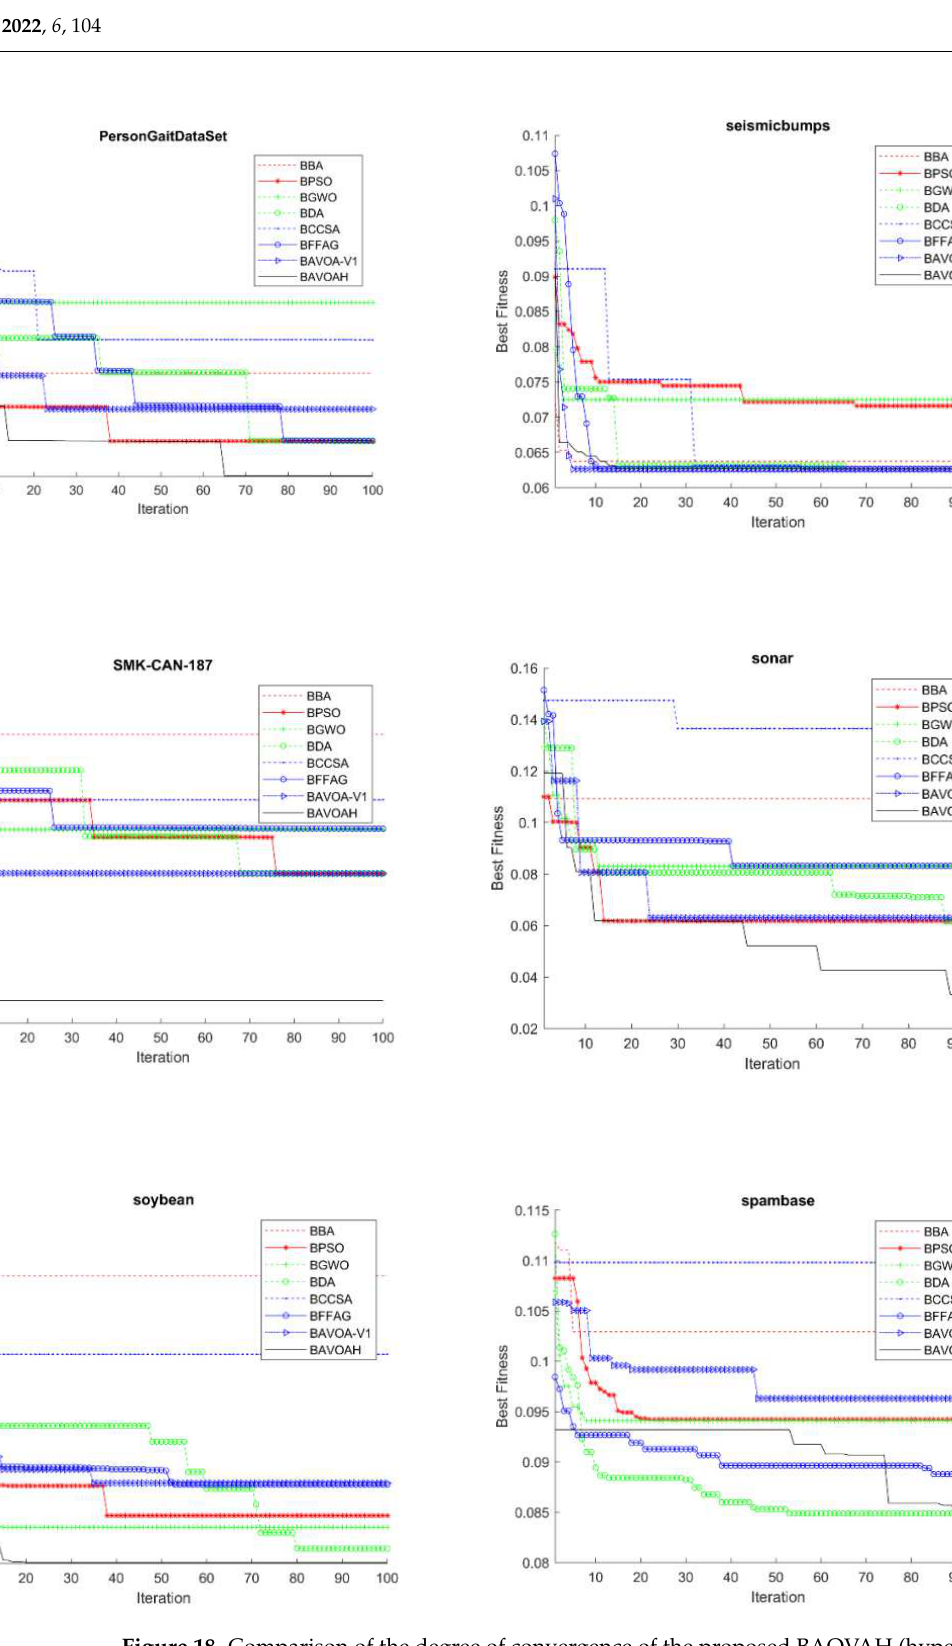
Figure 18. Comparison of the degree of convergence of the proposed BAOVAH (hyper-heuristic) and BAVOA-V1 (multi-strategy) method on the fourth six sets.